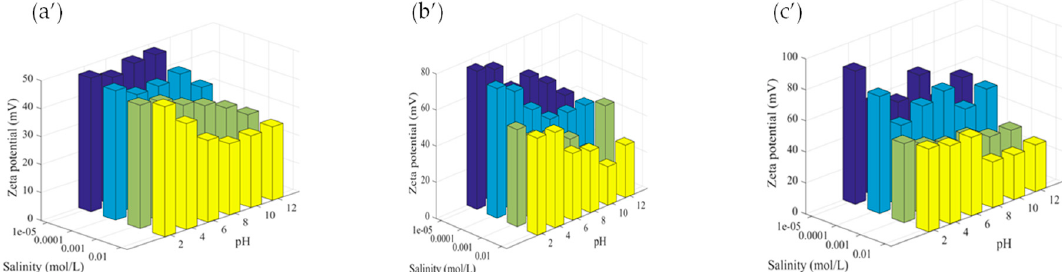
Figure 2. Zeta potential of empty Nps ( a’ ), BEONps ( b’ ) and OEONps ( c’ ) as a function of pH and salinity.